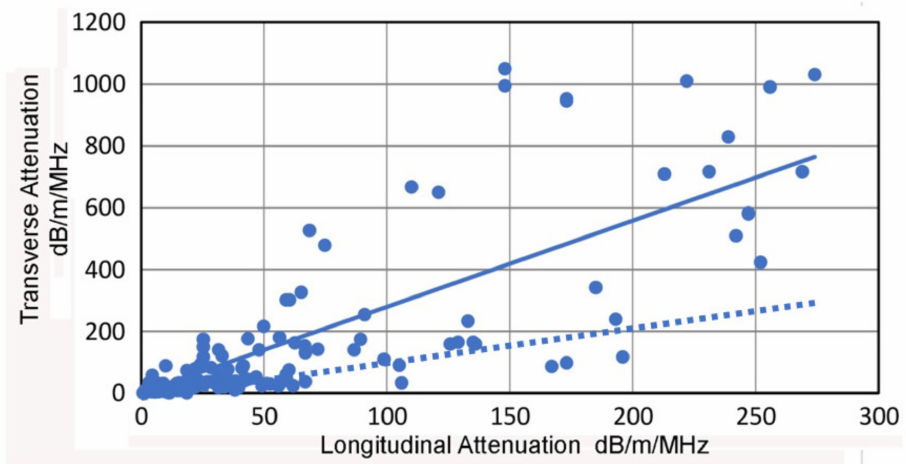
Figure 20. A cross-plot of longitudinal and transverse attenuation coefficients, α L and α T , of 159 various solids. Solid blue line: α T = 2.79 α L, dotted blue line: α T = α L . Data are from